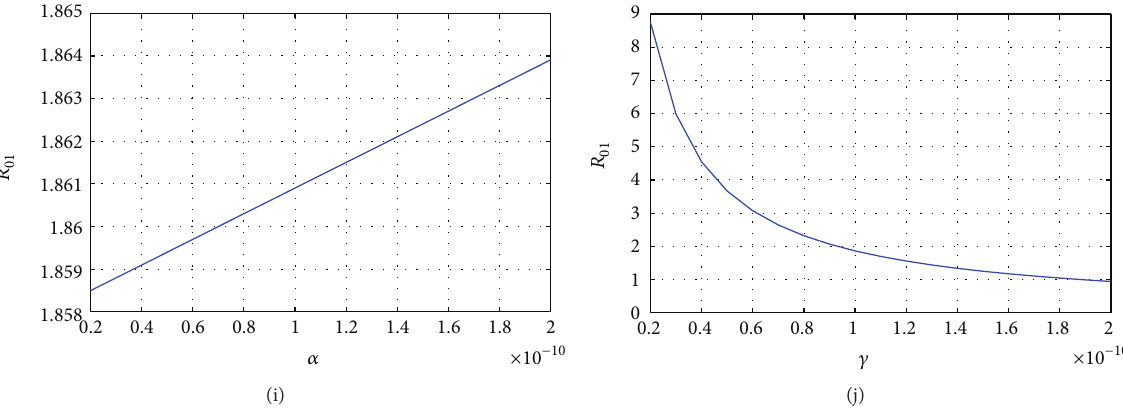
Figure 1: The sensitivity of 𝑅 01 in terms of